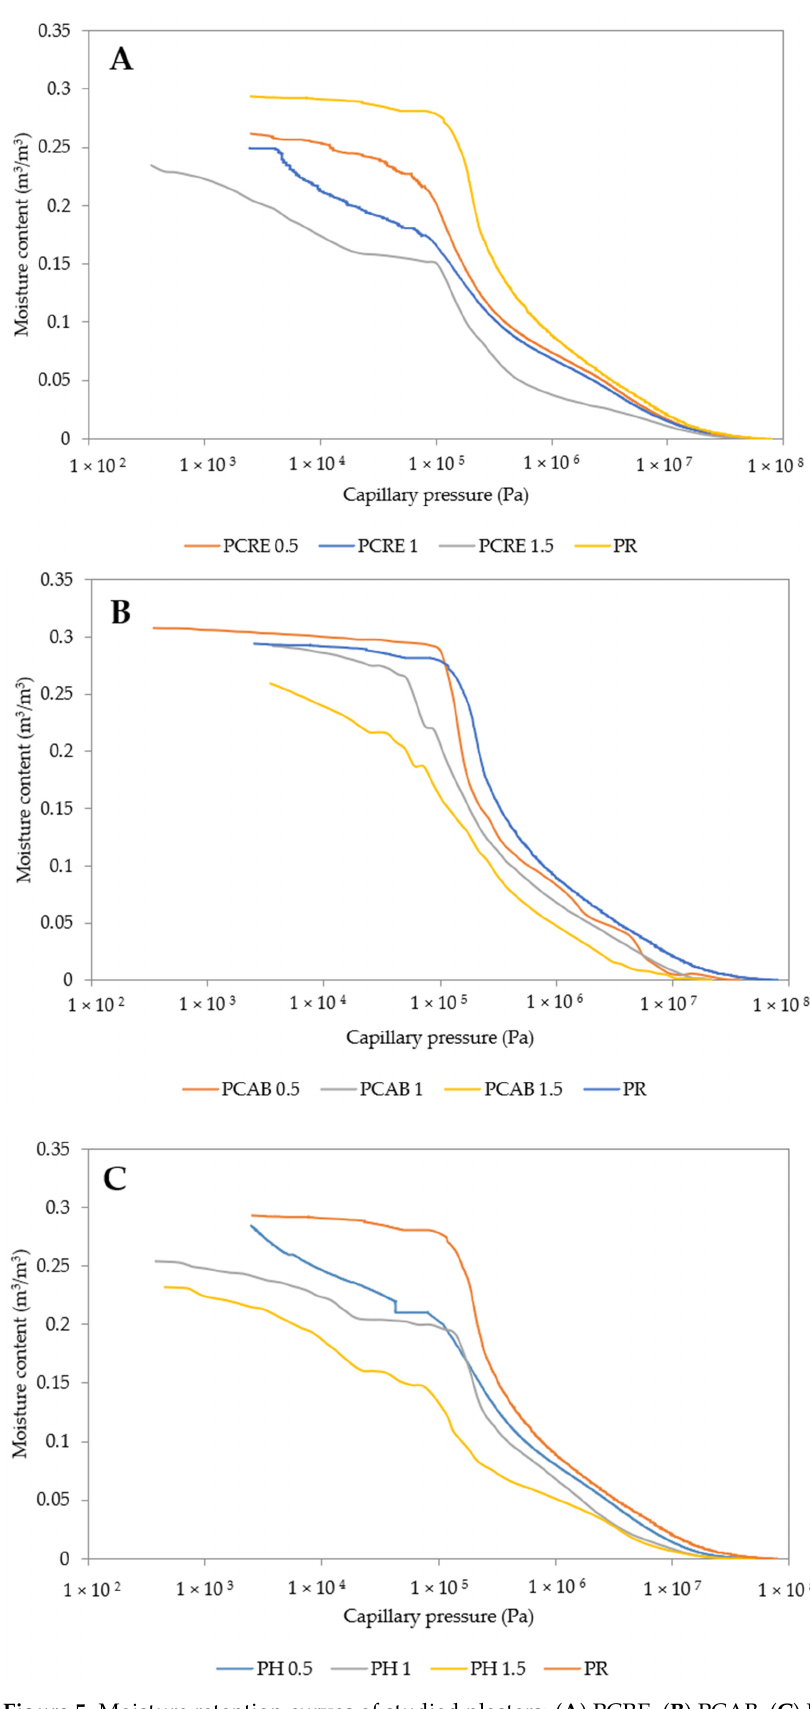
Figure 5. Moisture retention curves of studied plasters: ( A ) PCRE, ( B ) PCAB, ( C ) PH.